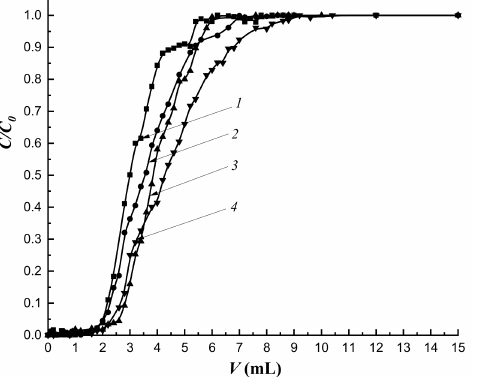
Figure 12. Dynamics of cholesterol sorption at the flow rate of the mobile phase 0.25 mL · min − 1 and a column height of 4.5 cm, C 0 = 16 mmol/L; 1 —CP-1; 2 —MIP-1-2; 3 —MIP-1-4; 4 —MIP-1-6. Table 8. The influence of the height of the sorption column on characteristics of the dynamic sorption of cholesterol. The flow rate of the mobile phase is 0.25 mL · min − 1 . Q sorb × 10 − 2 , q dyn × 10 − 2 , IF R , % Sorbent H , cm mmol mmol mL − 1 CP-1